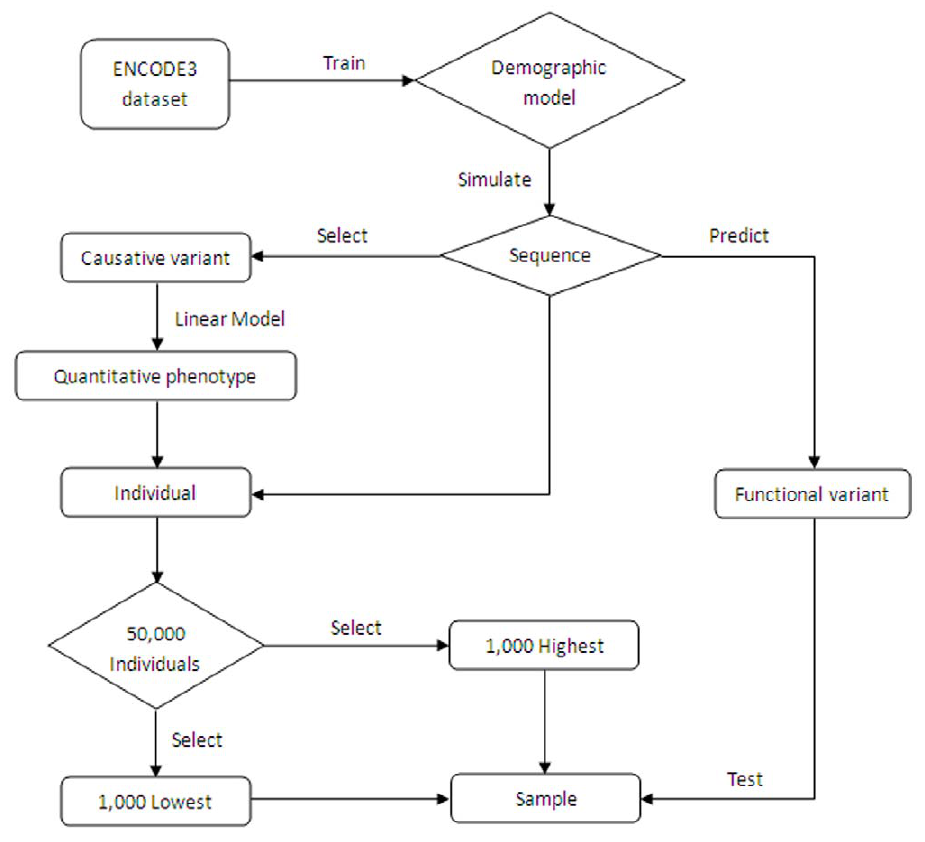
Figure 1. Flow chart of simulation studies.